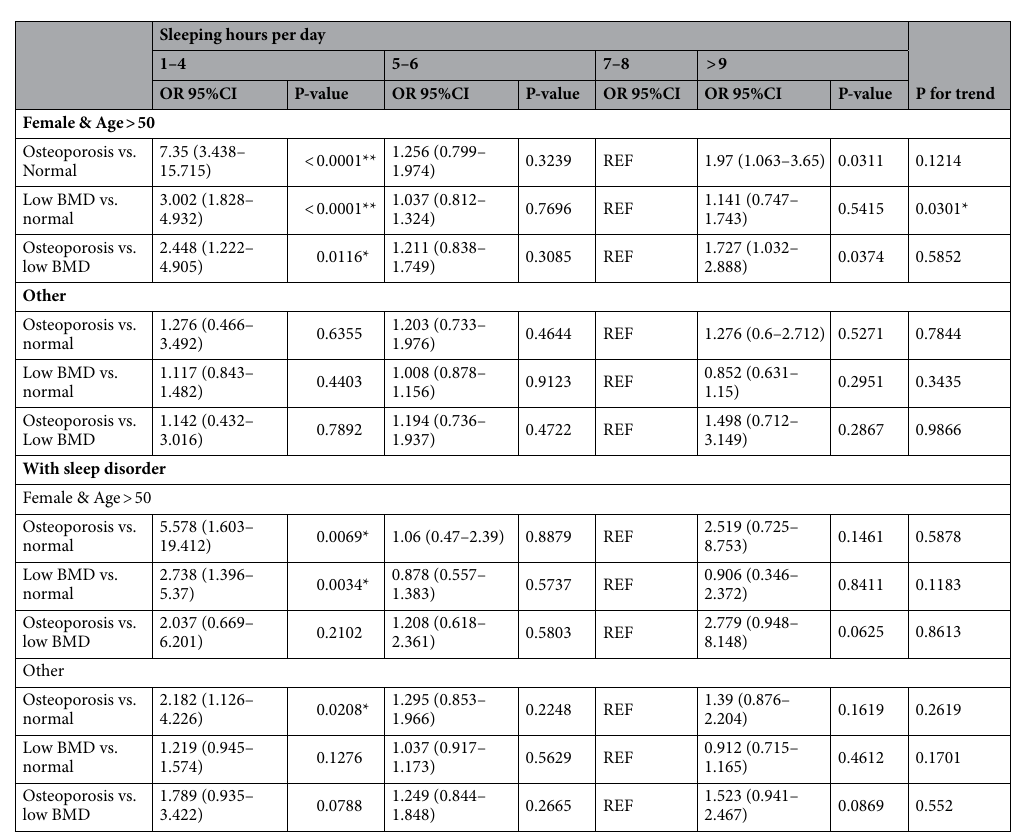
Table 4. Effect of sleep hours and sleep disorder in over fifty-year-old female on bone density in femoral neck. **There is significant difference P < 0.001. *There is significant difference P <